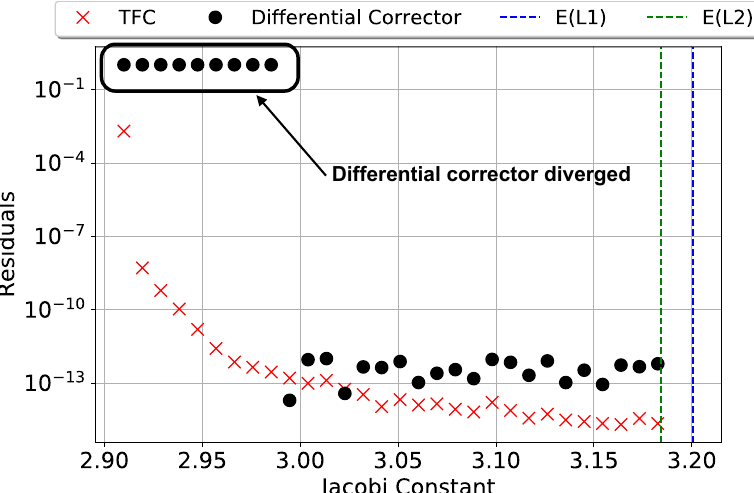
Figure 7. Maximum residuals of the loss vector for the TFC method solving for the trajectories plotted in Figure 2b as compared to the differential corrector. For the trajectories around L2, the differential corrector diverged around a Jacobi constant level of 3.00, while the TFC method was able to solve the problem with diminishing accuracy. The black box highlights the diverged cases.